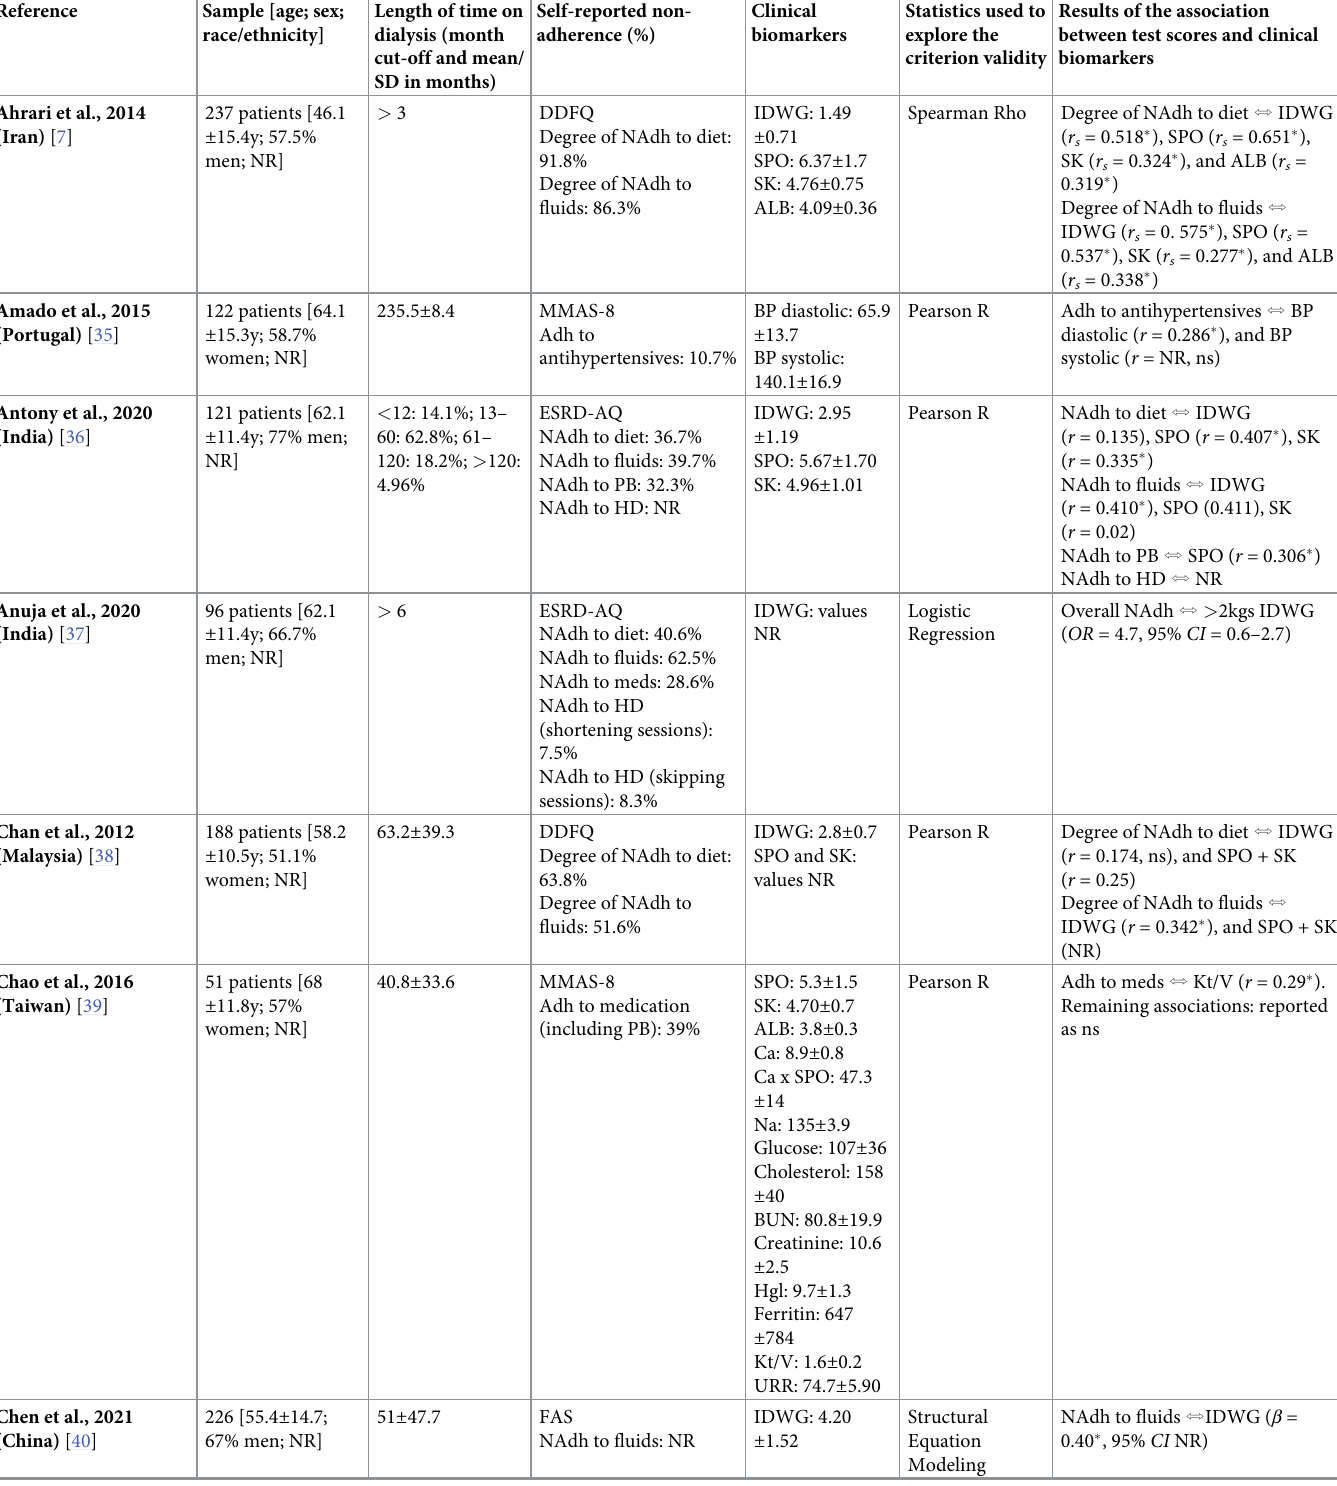
Table 1. Characteristics of the primary studies ( n = 29) and major